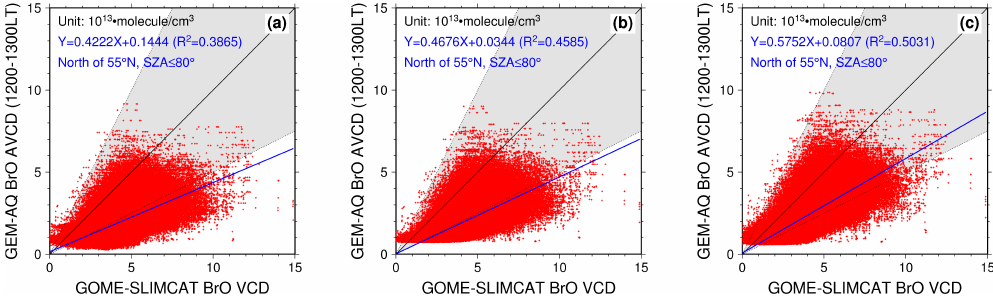
Fig. 12. The same as Fig. 10 but GEM-AQ BrO AVCDs from Run 3 are recalculated by adding extra BrO to the original model output: (a) 1pmolmol − 1 from the surface up to GEM’s dynamical tropopause; (b) 0.5pmolmol − 1 from the surface up to GEM’s dynamical tropopause and 1pmolmol − 1 from the dynamical tropopause up to the 100hPa level; and (c) 0.5pmolmol − 1 from the surface up to GEM’s dynamical tropopause and 3pmolmol − 1 from the dynamical tropopause up to the 200hPa